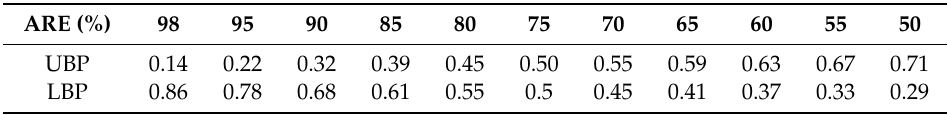
Table 2. Upper breakdown points (UBPs) and lower breakdown points (LBPs) of the PITS estimator for di ff erent ARE